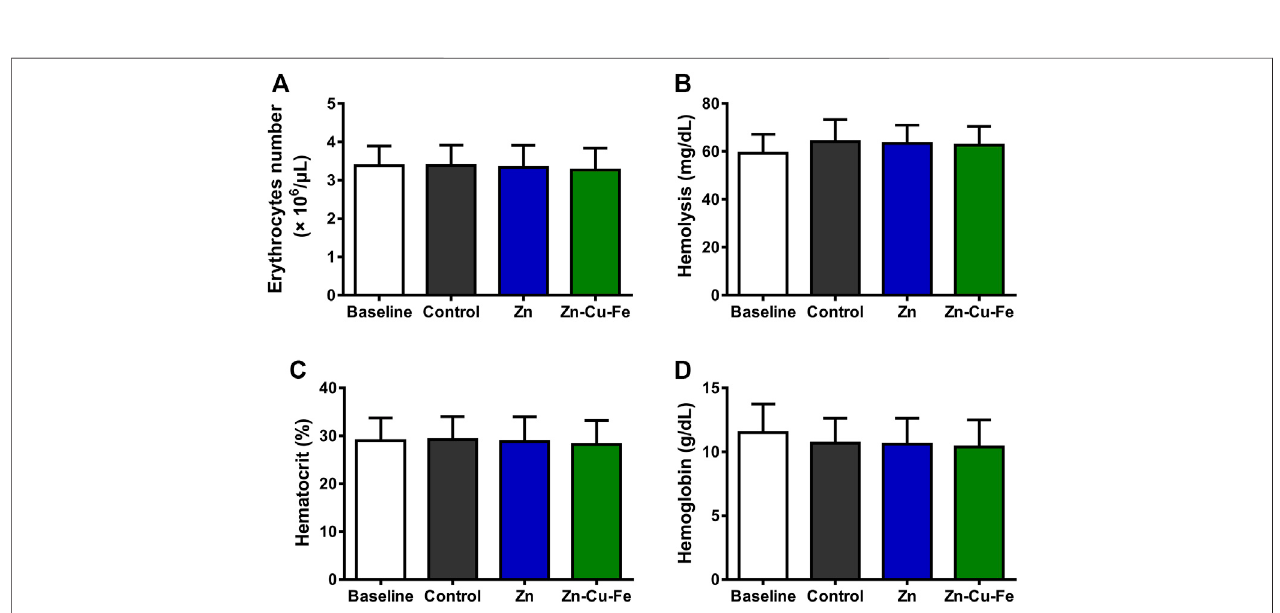
FIGURE 7 | Hematological parameters were analyzed before (baseline) and after 60 min of circulation using the Chandler-Loop model: (A) the number of erythrocytes(10 6 / μ L), (B) hemolysiscalculatedbytheamountofcyanhemoglobin(mg/dl), (C) hematocritvalues(%),and (D) hemoglobinconcentrations(g/dl).Bloodin the empty tubing after circulation was considered a